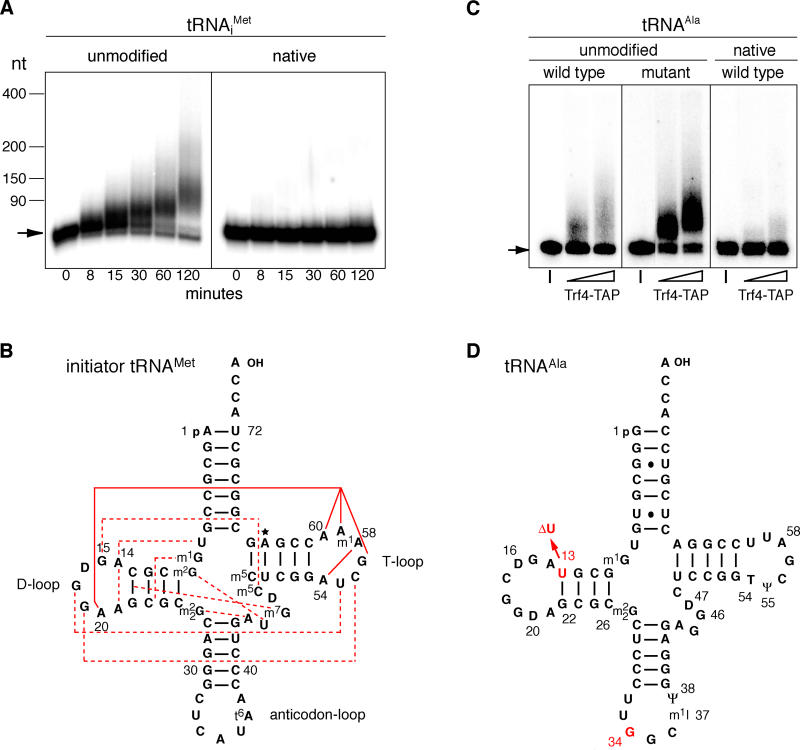
The Trf4 Complex Preferentially Polyadenylates Unmodified tRNAi
Met and the Unmodified A34GΔU13 Mutant of tRNAAla
(A) Polyadenylation assay with Trf4p-TAP and unmodified and native tRNAi
Met as substrates. The 5′-end-labeled tRNAs were incubated with 50 ng of Trf4 complex for times indicated and resolved by gel electrophoresis. The migration position of the input tRNA is indicated by an arrow.(B) Sequence of yeast tRNAi
Met in cloverleaf form with all the known nucleotide modifications. Tertiary interactions are indicated in solid and dashed red lines. The network of hydrogen bonds involving A20, G57, m1A58, A59, and A60, necessary and unique for tertiary interactions in eukaryotic initiator tRNA, is outlined by solid red lines. A*, 5′-phosphoribosyl-2′-adenosine; D, dihydrouridine; m1A, 1-methyladenosine; m1G, 1-methylguanosine; m2G, N2-methylguanosine; m2
2G, N2,N2-dimethylguanosine; m7G, 7-methylguanosine; t6A, N6-threonylcarbamoyladenosine.(C) Polyadenylation activity of Trf4p-TAP on unmodified wild-type, A34GΔU13 mutant tRNAAla, and native tRNAAla. The 5′-end-labeled tRNAs were incubated with 20 or 50 ng of Trf4 complex for 30 min at 30 °C. Lane I in each panel shows input tRNA. tRNAs were separated on 10% denaturing gels.(D) Yeast tRNAAla in its cloverleaf form. All known nucleotide modifications are indicated. In the mutant tRNAAla used in this study, the uracil at position 13 was deleted, and the A34 in the anticodon loop was changed to guanine (marked in red). ψ, pseudouridine; m1I37, 1-methylinosine generated by deamination of adenosine at position 37. Other modifications are labeled as in (B).